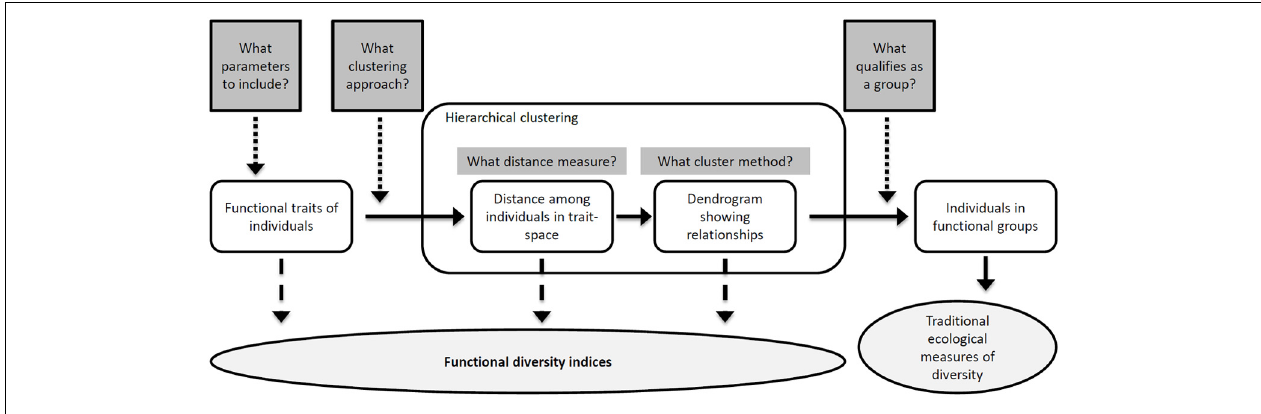
FIGURE 2 | The process of producing a functional classification (unshaded objects) of individuals in natural community samples. At different steps of the sequential process, which contains a number of critical decisions, different measures of FD (shaded ellipse) can be estimated (see